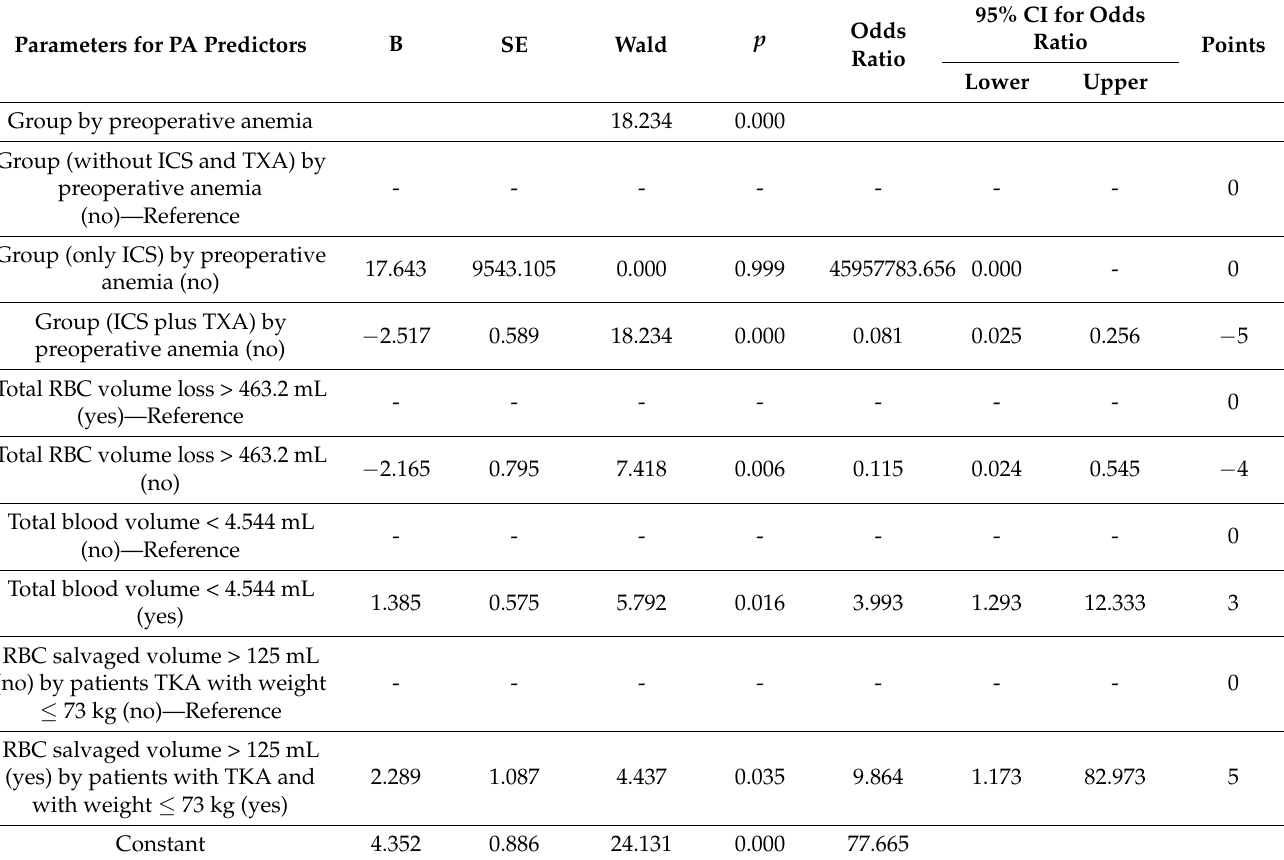
Table 5. Parameters for PA predictors in multivariate logistic regression model with appropriate points for Post-Operative Index score construction in patients with hip or knee arthroplasty.